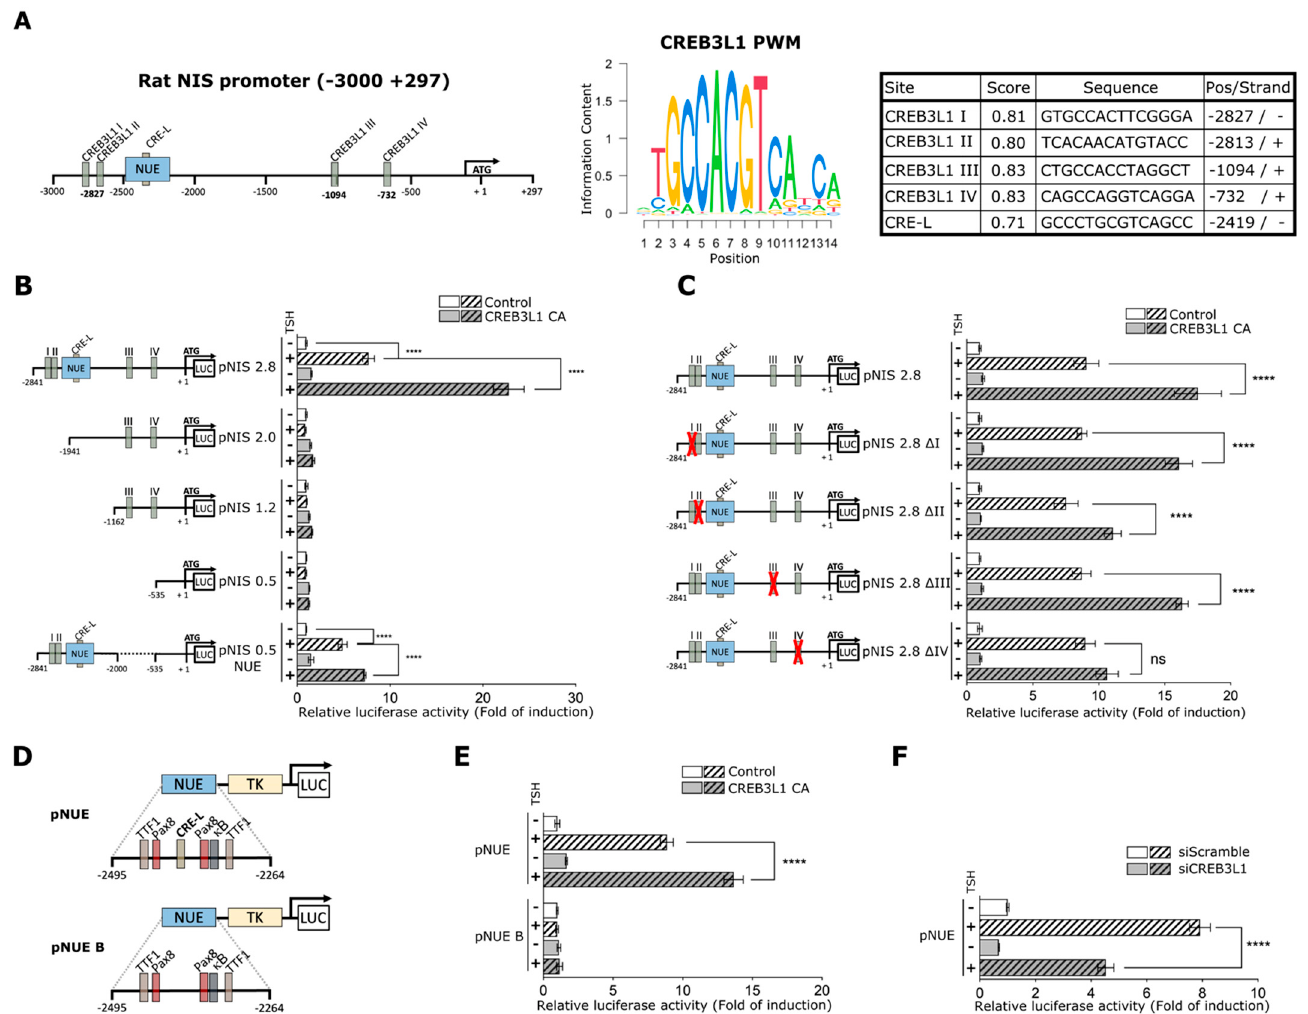
Figure 5. CREB3L1 modulates NIS promoter activity. ( A ) Left panel: schematic representation of the analyzed region of the NIS promoter, including the NUE, and the putative CREB3L1-binding sites. Right panel: CREB3L1 PWM determined by JASPAR and the score analysis of each of the putative binding sites by using TFBSTools. CRE-L element inside the NUE is also included. ( B , C ) Relative luciferase activities of the indicated NIS promoter constructs or mutants transiently co-transfected into FRTL-5 cells with either pEGFP or pcDNA (as the controls in B and C, respectively) or a plasmid expressing a constitutive active version of CREB3L1, CREB3L1 CA, for 12 h. After transfection, the cells were deprived of TSH for 72 h ( − ) and stimulated with TSH for 8 h (+). ( D ) Schematic representation of the pNUE and pNUE B constructs with a detailed description of the transcription factor-binding sites reported inside the region. ( E , F ) Relative luciferase activities of the indicated constructs transiently co-transfected into FRTL-5 cells with either CREB3L1 CA or pEGFP (control) ( E ), and siCREB3L1 or siScramble ( F ) for 12 h. The cells were then treated as in B and C. The results are expressed as luciferase activity normalized to β -galactosidase and relative to basal activity for each construct. Bar graphs represent the means ± SEM of four independent experiments (**** p < 0.0001; ns: not statistically significant) .